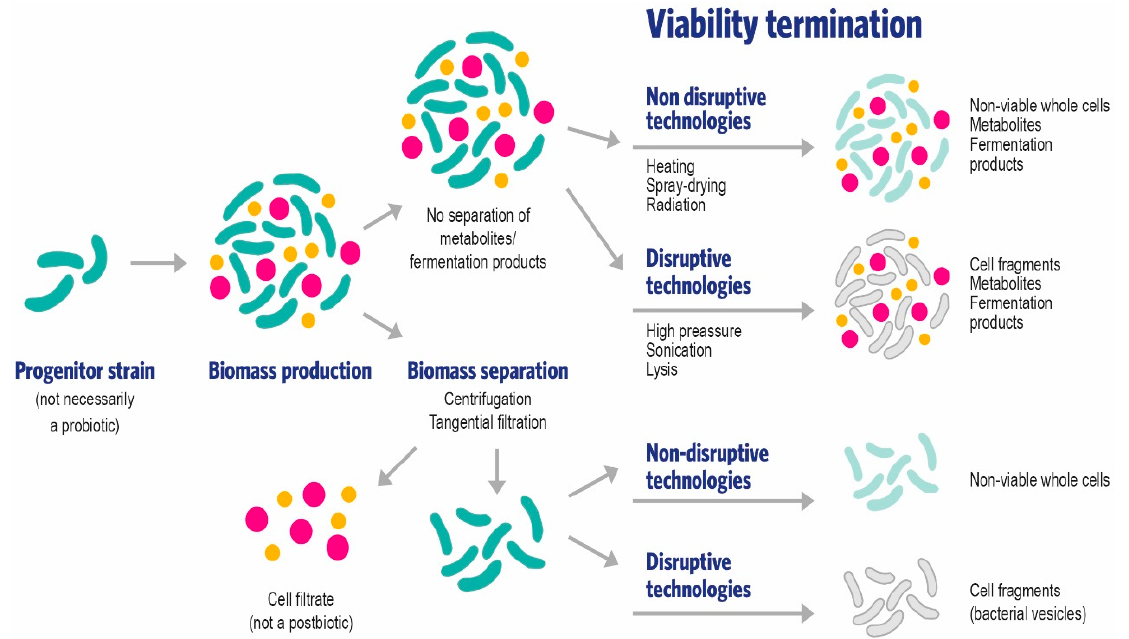
Figure 2. Proposed technological paths for the preparation of inanimate cultures composed of whole cells or their fragments, with and without metabolites or fermentation products, before the assessment of the postbiotic capacity through a high-quality efficacy study on the target host. Although yoghurt is defined by the Codex Alimentarius [29] to include live starter cultures, a product known as ambient yoghurt has emerged. Ambient yoghurt is conven- tional yoghurt that is subjected to thermal treatment in order to inactivate starter cultures.